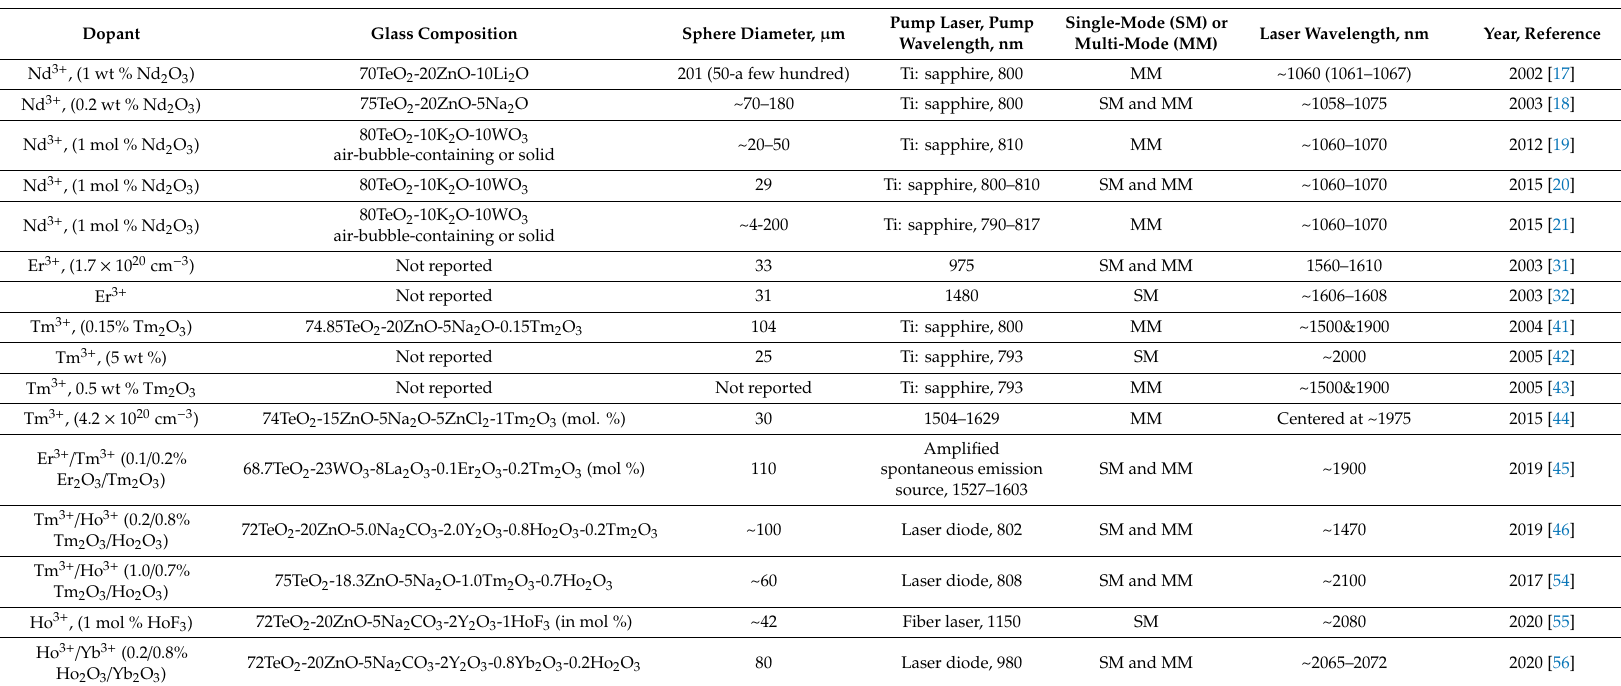
Table 2. Summary of performance of rare-earth doped tellurite glass microsphere